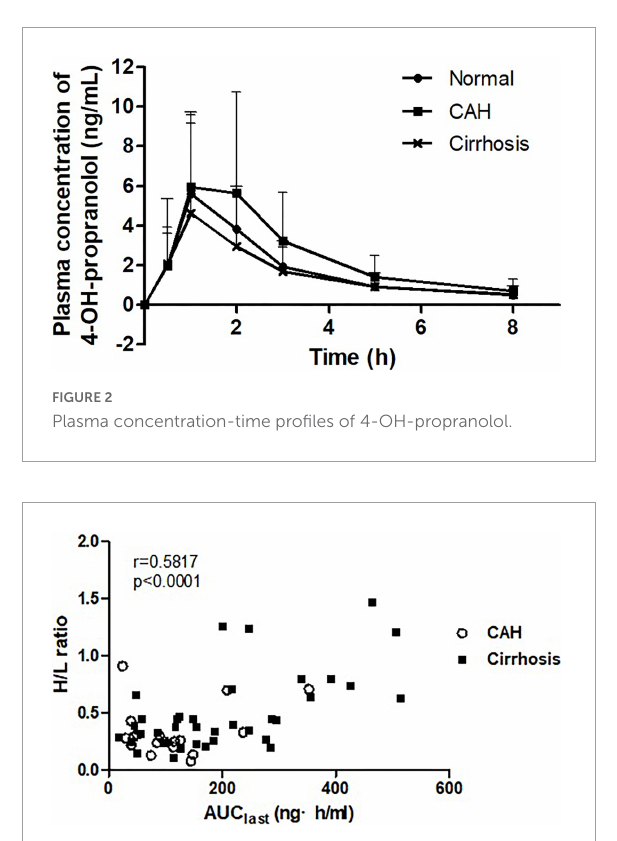
FIGURE3 The correlation between systemic exposure of propranolol (AUC last ) and portal blood flow (H/L